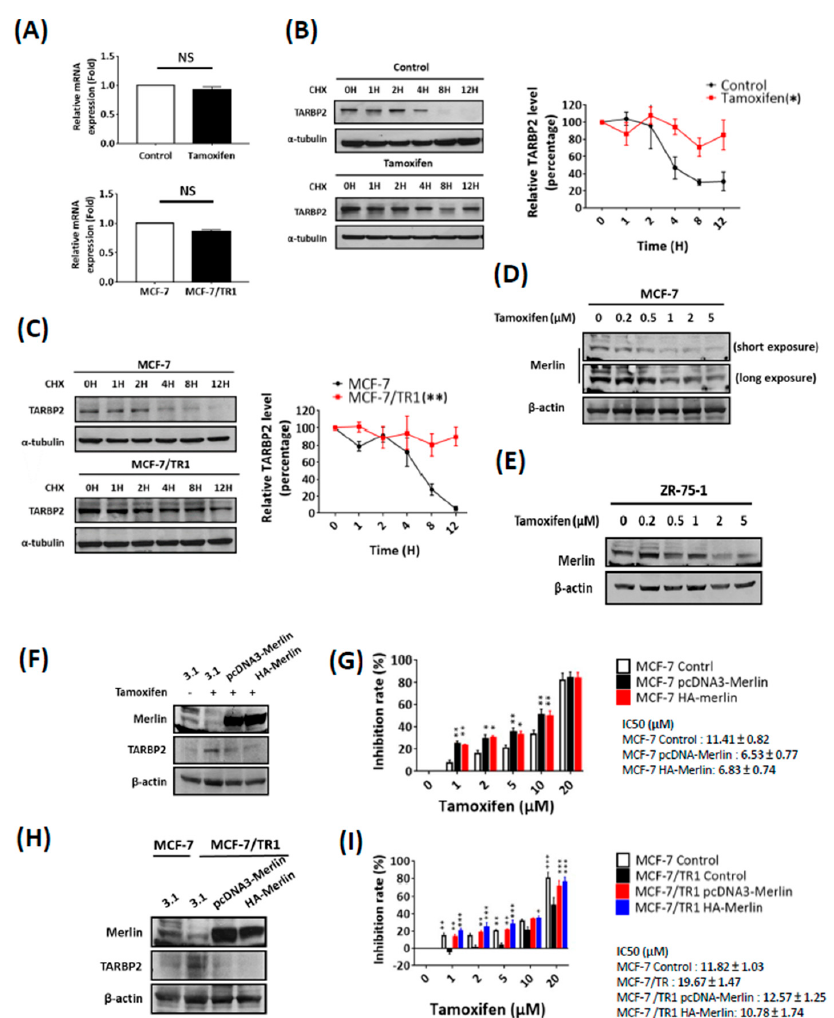
Figure 5. Tamoxifen stabilizes TARBP2 through downregulation of Merlin. ( A – C ) Tamoxifen enhanced the protein stability of TARBP2. RNA was isolated from cells (MCF-7 cells were pretreated with 2 µ M tamoxifen for 48 h; MCF-7/TR1 cells was seeded in plates and cultured until they reached 70–80% confluence in the presence of tamoxifen) to analyze the mRNA level of TARBP2 by reverse-transcription PCR (qRT-PCR). The experiments were repeated at least 3 times ( A ). Cells as indicated in ( A ) were treated with 50 μ g/mL cycloheximide to block protein synthesis and were harvested at the indicated time point to analyze the expression of TARBP2 by western blotting ( B , C ). The degradation rates were plotted for the average ± SEM of at least three independent experiments and analyzed by two-way ANOVA. * p ≤ 0.05, ** p ≤ 0.01. ( D – I ) Role of Merlin in tamoxifen sensitivity through regulation of TARBP2 expression. MCF-7 ( D ) and ZR-75-1 ( E ) cells were treated with increasing concentrations of tamoxifen for 48 h, and western blot was performed to detect the expression of TARBP2 and Merlin. MCF-7 and TR1 cells were transfected with the indicated plasmids to overexpress Merlin for 24 h; cells were then collected to analyze the expression of TARBP2 and Merlin ( F , H ). Cells as indicated in ( F , H ) were treated with different concentrations of tamoxifen (1, 2, 5, 10, 20 µ M) for 72 h, and cell proliferation was determined by MTT assay ( G , I ). All MTT results are presented as the means ± SEM from at least three separate experiments that were performed in duplicate or triplicate and analyzed by two-way ANOVA. * p ≤ 0.05, ** p ≤ 0.01, *** p ≤ 0.001.